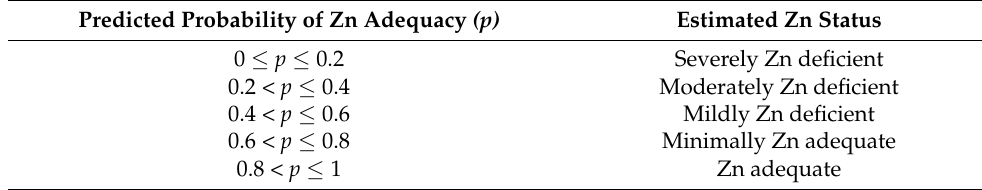
Table 5. Estimated Zn status based on preliminary ranges of predicted probability ( p ) of Zn adequacy. Predicted Probability of Zn Adequacy (p) Estimated Zn